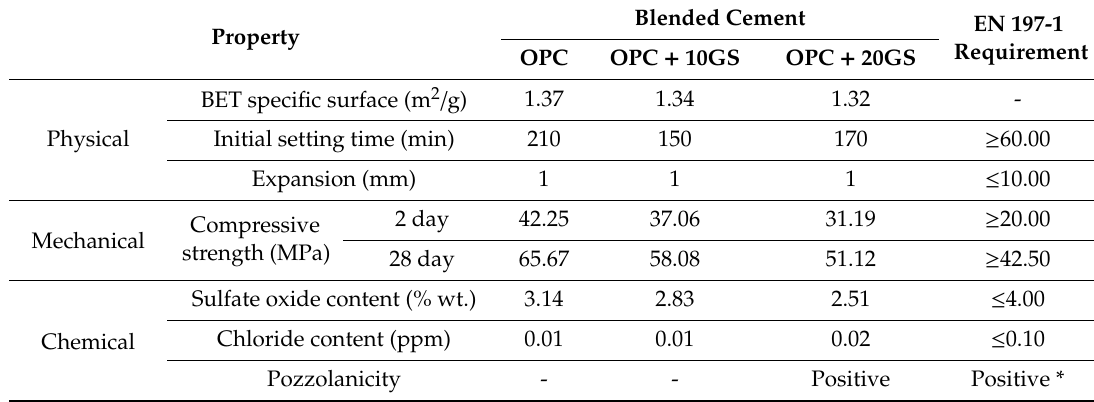
Table 1. New cement physical, mechanical, and chemical properties.